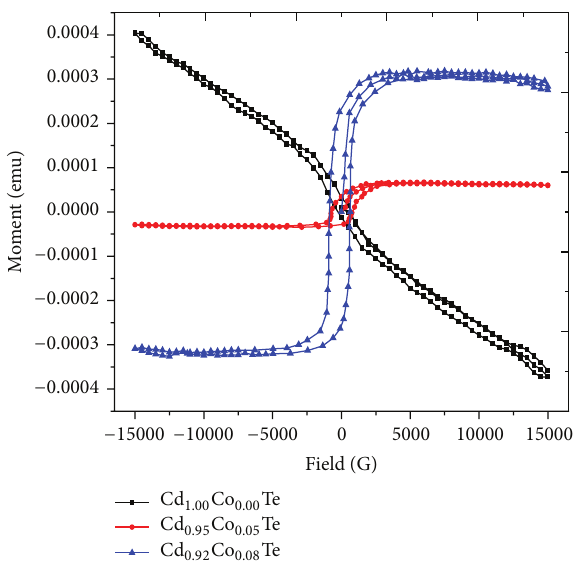
Figure 6: Plot of magnetization versus magnetic field of pure CdTe and Co doped CdTe alloy